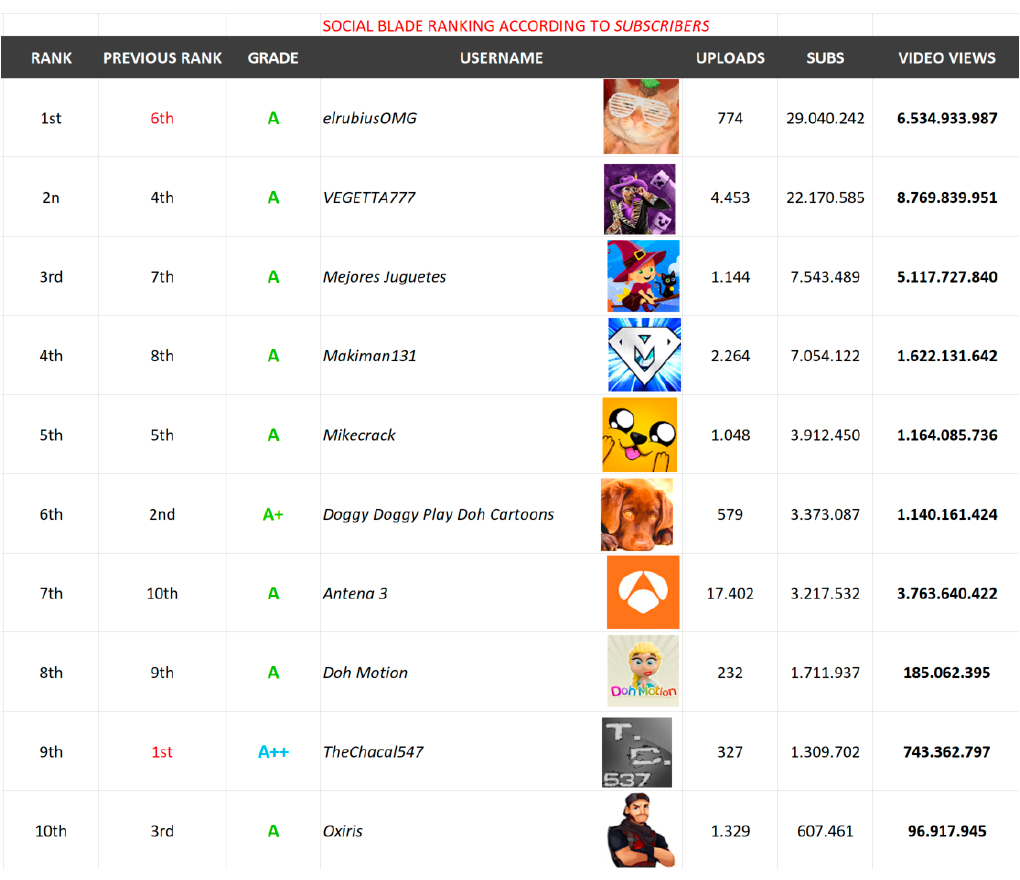
Figure 8. Front page of the YouTube channel, MEJORES JUGUETES.